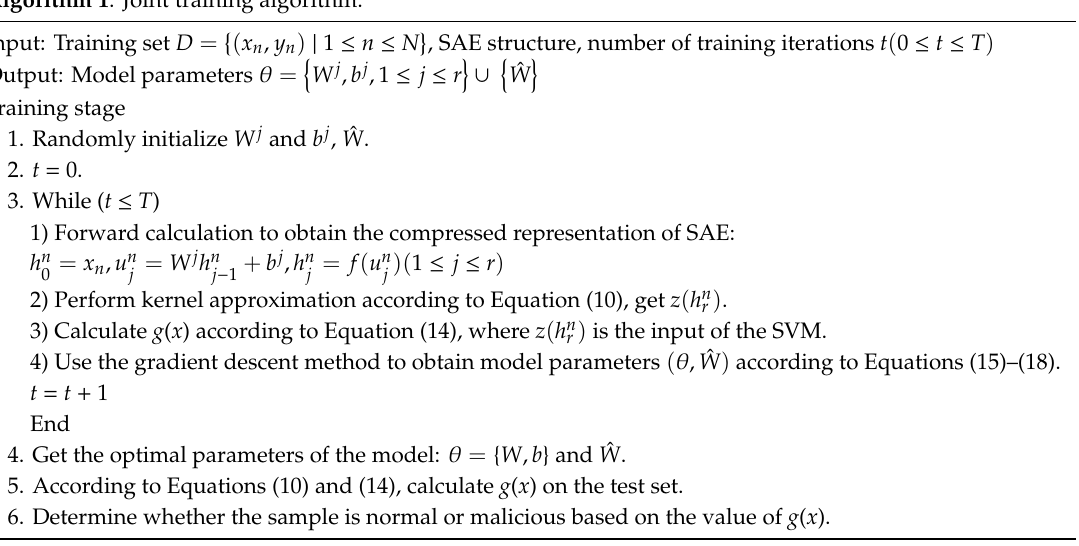
Algorithm 1 : Joint training